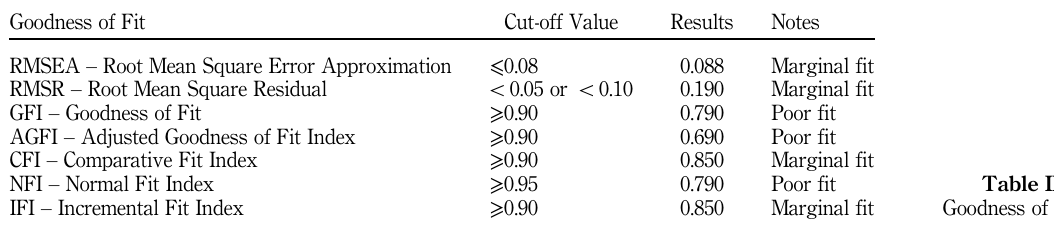
Table III. Goodness of